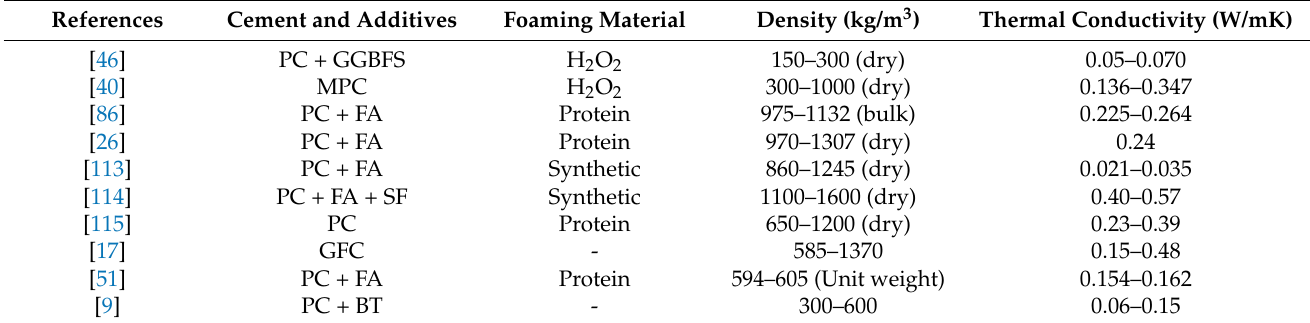
Table 12. Thermal conductivity results of different